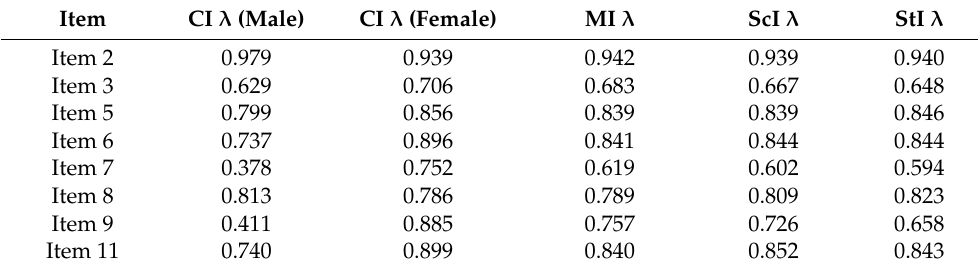
Table 3. Standardized factor loadings ( λ ) for invariance models.